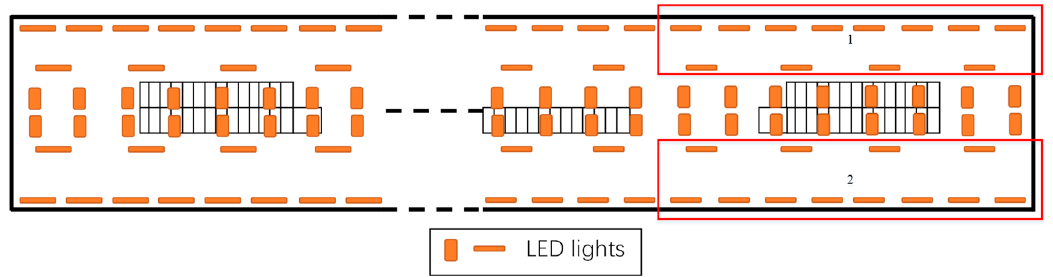
Figure 9. Deployment of the proposed system in the concourse level of the metro station. Comparison experiments were performed in Zones 1 and 2, which were symmetric and had the same number of LEDs. The smart lighting system was implemented in zone 1, while the normal lighting system was used in zone 2.